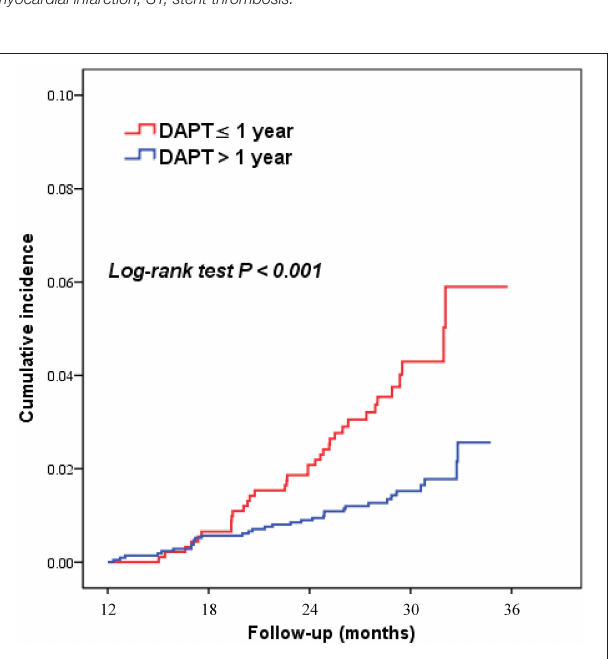
FIGURE 2 | Kaplan–Meier curves for major adverse cardiovascular and cerebrovascular events according to DAPT duration ( > 1 year vs. ≤ 1 year) in patients with elevated Lp(a) levels. DAPT, dual antiplatelet